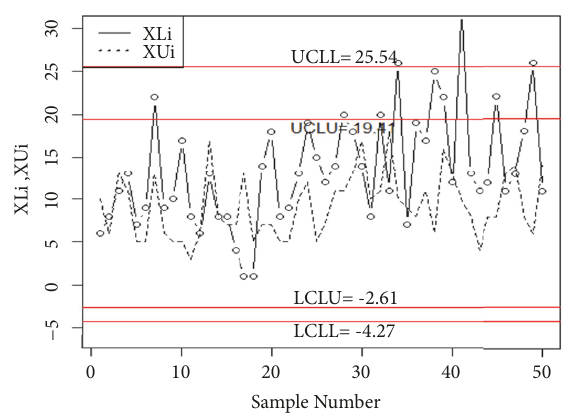
Figure 1: The proposed control chart for simulated